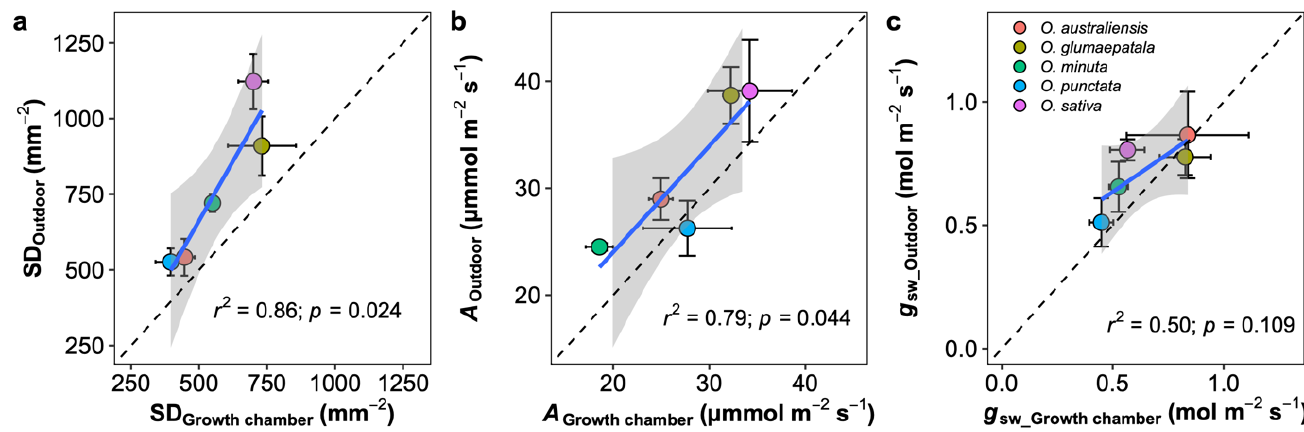
Figure 6. Leaf traits comparison between the outdoor and growth chamber plants. ( a ) Stomatal den- sity per leaf area (SD), ( b ) net photosynthetic rate (A), and ( c ) stomatal conductance to vapor (gsw). Blue line represents the linear regression line; black dot line represents the 1:1 line; and the grey shaded area corresponds to the 95% confidence region of the regression line. Data are shown with mean ± SE; n = 5 individual plants.